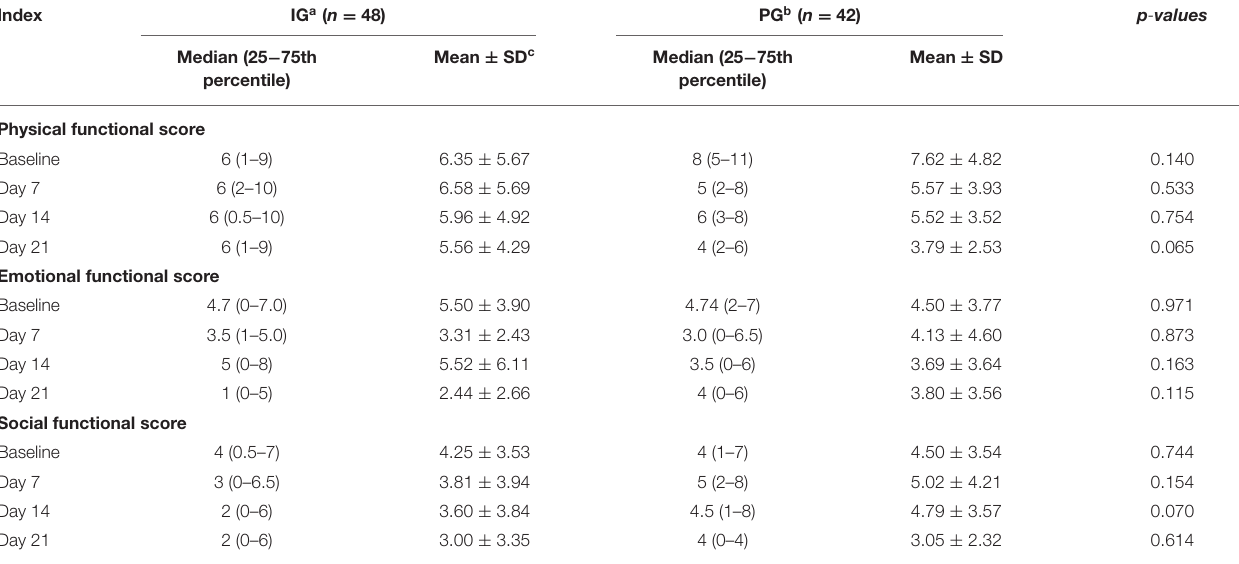
TABLE 4 | Effect of intervention on PedsQL TM family impact